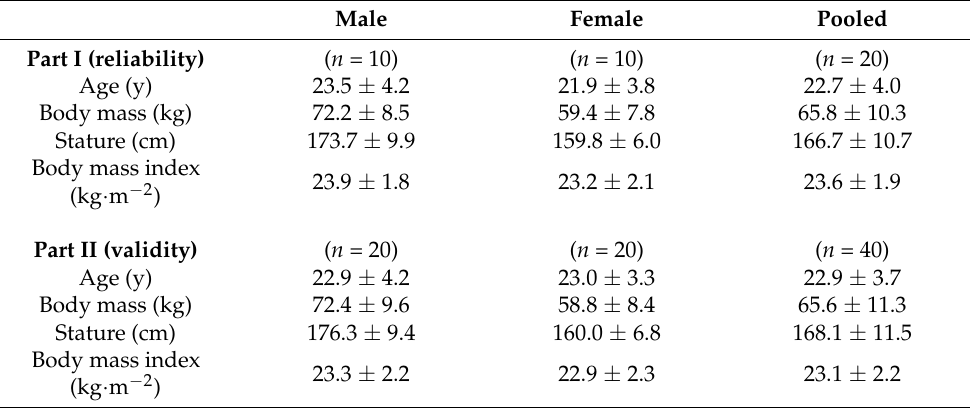
Table 1. Physical characteristics of athletes involved in Part I (reliability) and Part II (validity) of the 3-min burpee test (3-MBT) study. Male Female